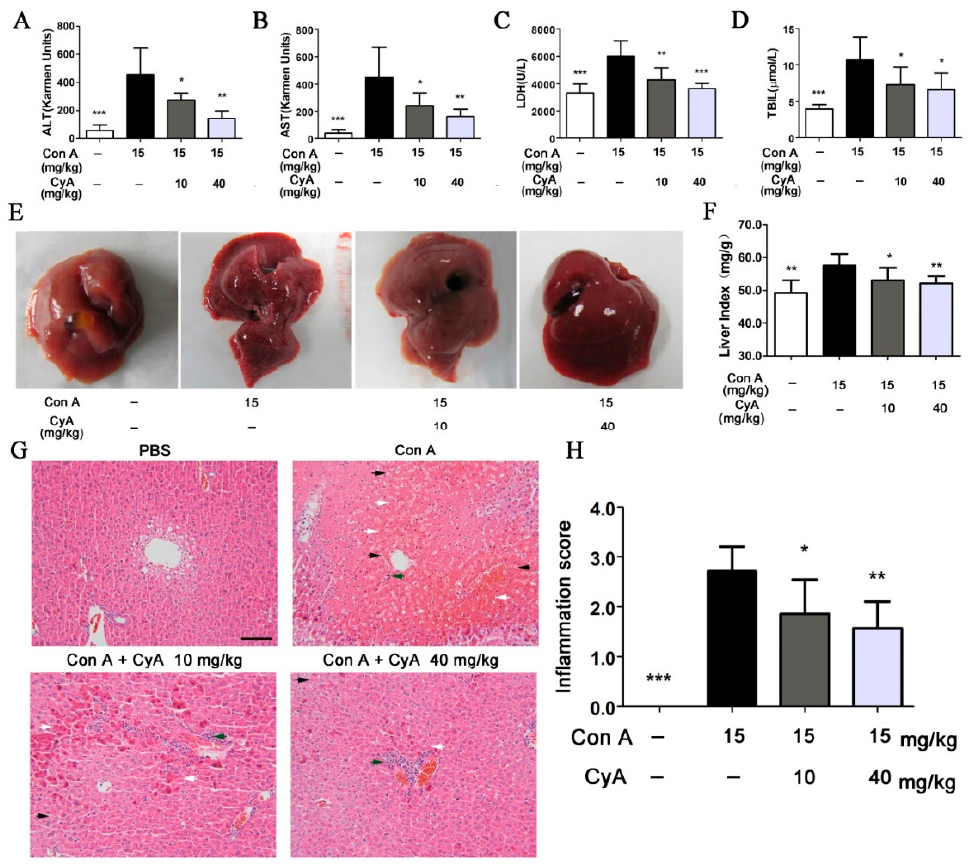
Figure 4. CyA inhibited Con A-induced liver injury in mice . Mice were treated in the same way as